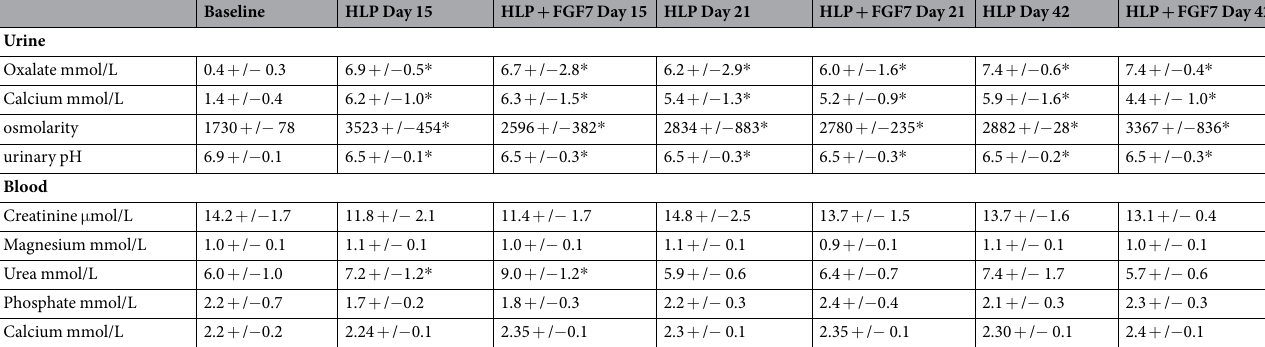
Table 1. Plasma and urinary parameters at baseline, in HLP and in HLP + FGF7 groups at days 15,21 and 42. * Indicates a p value < 0.05 compared to